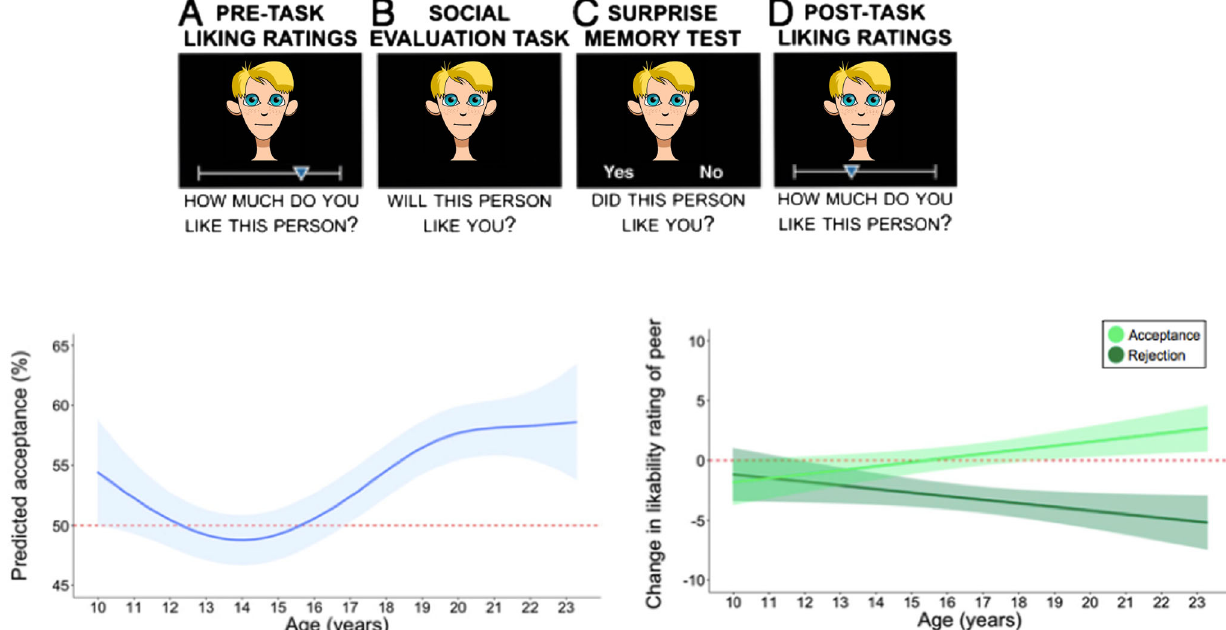
Fig. 2 Adolescents ’ expectations and adjustments of being liked and liking others. Social evaluation study in which participants between ages 10 and 23 years rated other peers on whether they liked the other person, whether they believed the other would like them, and a post scan rating of liking the other person after having received acceptance or rejection feedback from the other person. The faces used in this adaptation of fi gure are cartoon approximations of the original stimuli used in ref. 40 ; to see the original stimuli, please refer to ref. 40 . The left graph shows that adolescents expect least to be liked by the other before receiving feedback (question B). The right graph shows a developmental increase in distinguishing between liking and disliking based on feedback from the other person (question D). (Adapted with permission from Rodman, 2017, PNAS 40